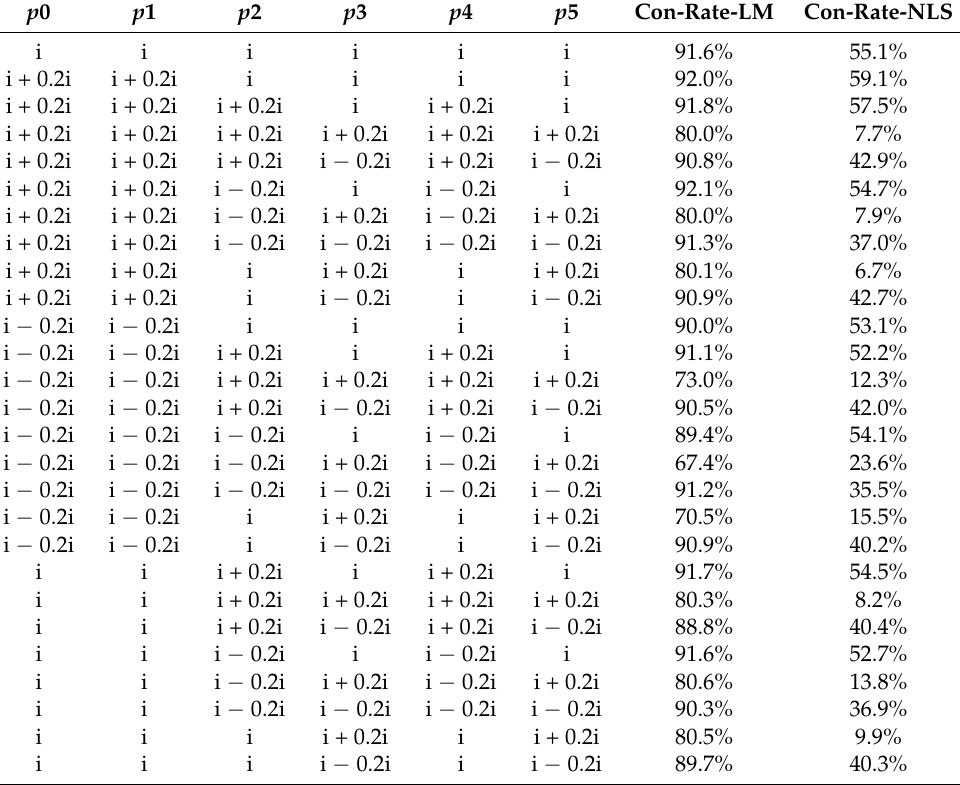
Table 1. Convergence rate of fitting double-logistic equations with different initial values.